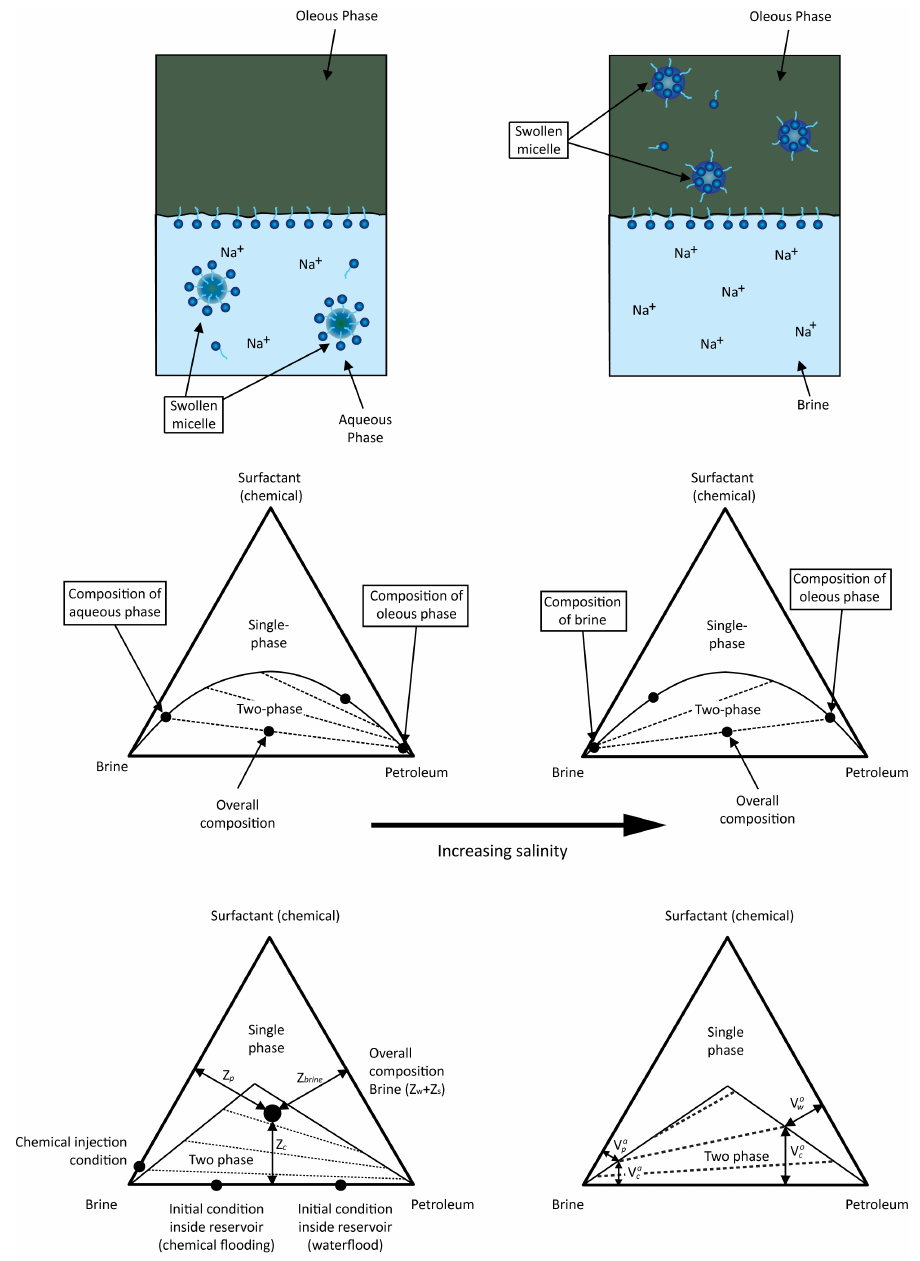
Figure 4. Ternary phase diagrams for Type II( − ) ( left ) and II(+) ( right ) systems ( top ) and their simplified representations ( bottom )